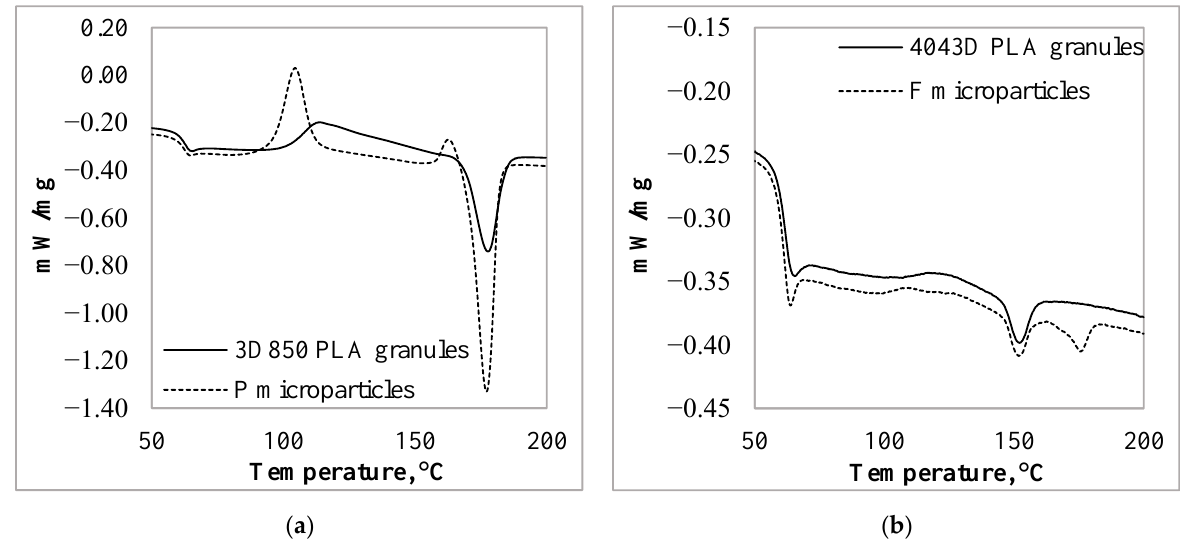
Figure 6. PLA granules and microparticles second heating DSC curves in the case of ( a ) 3D850 granules; ( b ) 4043D granules.